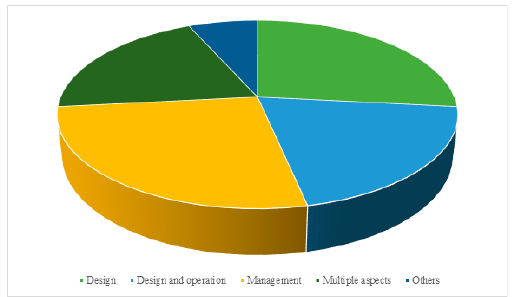
Figure 3. Distribution of research performed on different fields based on transportation.